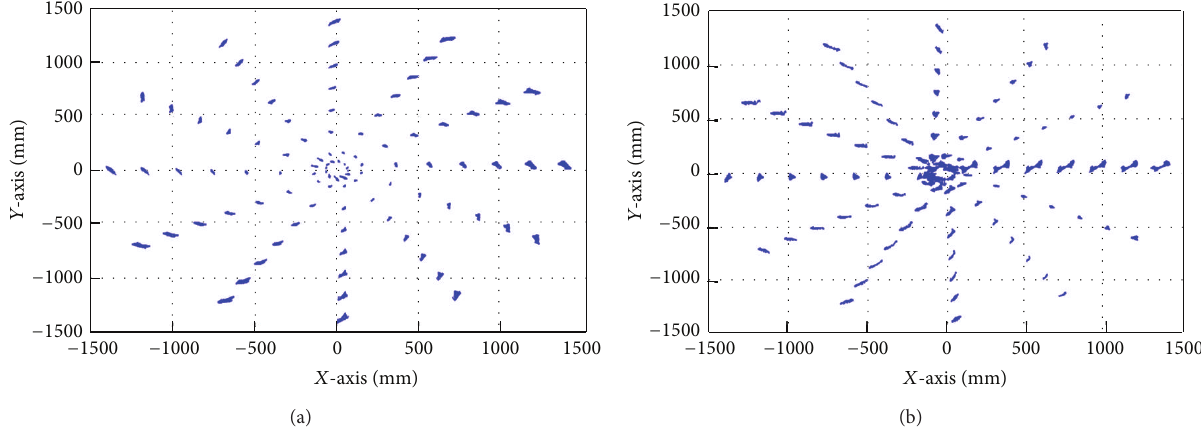
Figure 17: Uncompensated errors (a). Compensated errors (b). Vector